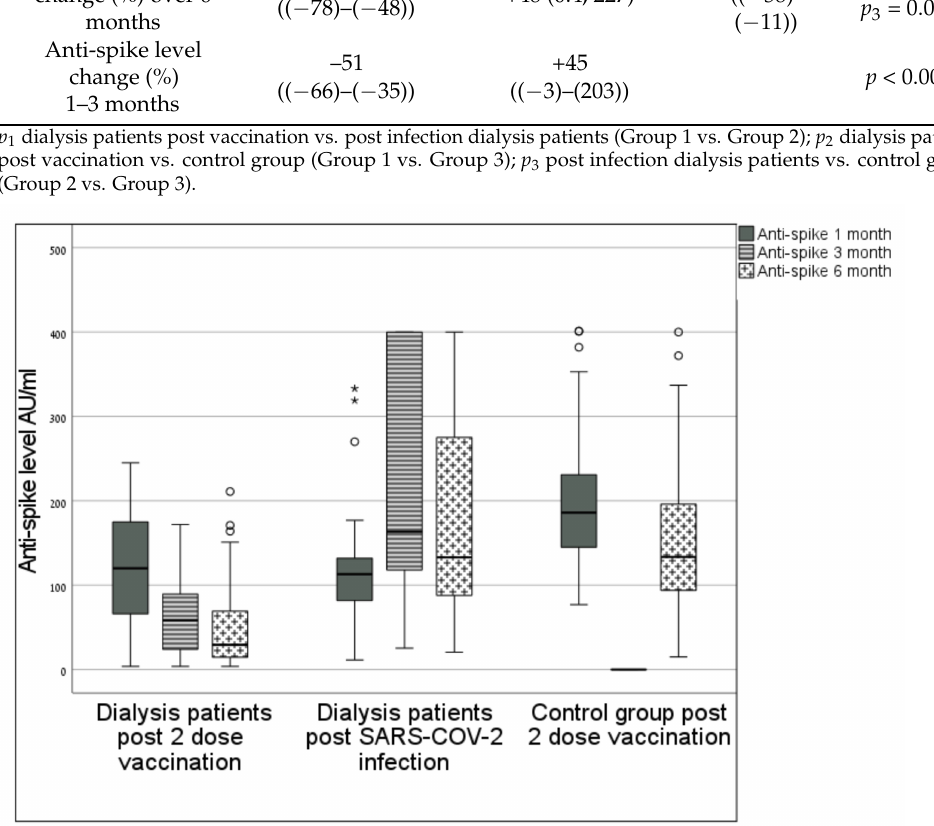
Figure 2. Anti-spike antibody level at 1, 3 and 6 months. Box plot diagram of anti-spike antibody levels: median, 25–75 percentiles and distribution, measured at 1, 3 and 6 months in dialysis patients post vaccination (left) and dialysis patients post infection (middle); and measured at 1 and 6 months in the control group (right); ** means significant